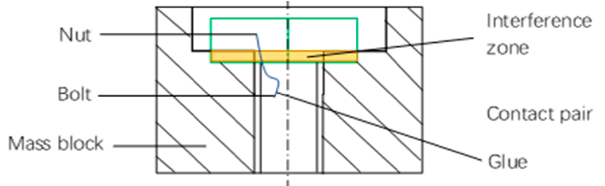
Figure 9. The definition of interference between nut and mass block.